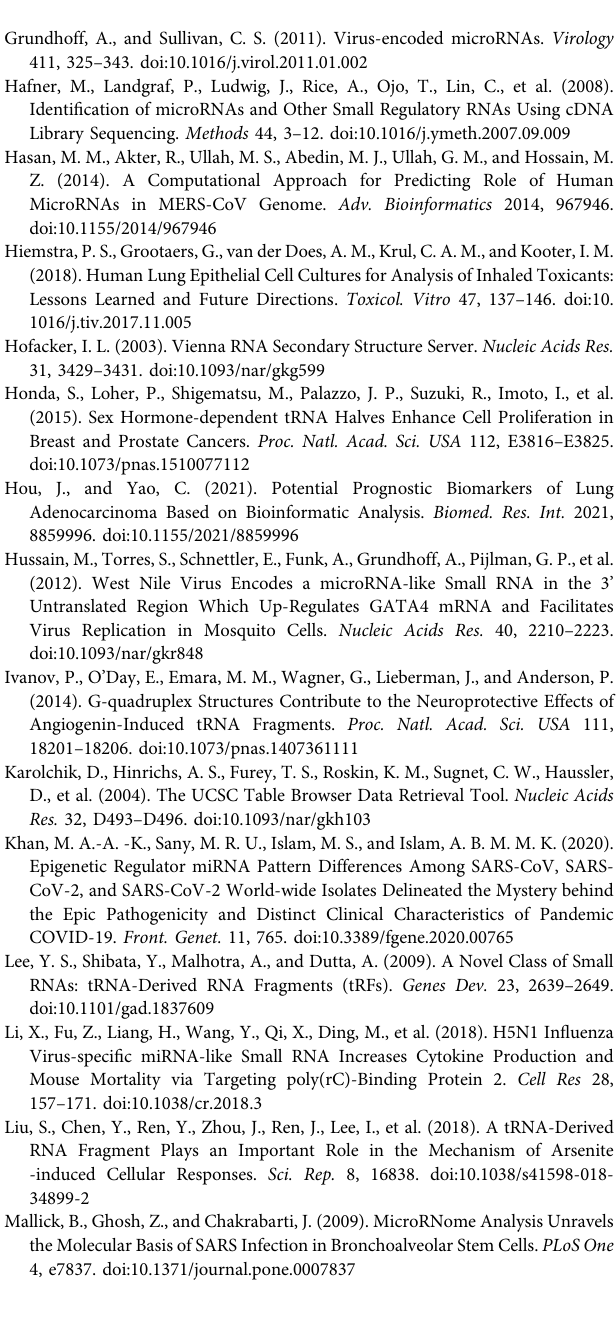
analyses. Supplementary Figure 2 | Biogenesis of tRF5s and tRF5DC. tRF5s are generated bythe cleavageon theanticodon loop(black arrows); tRF5DCs arederived from the cleavage on the D arm (red or blue arrow) and anticodon loop (black